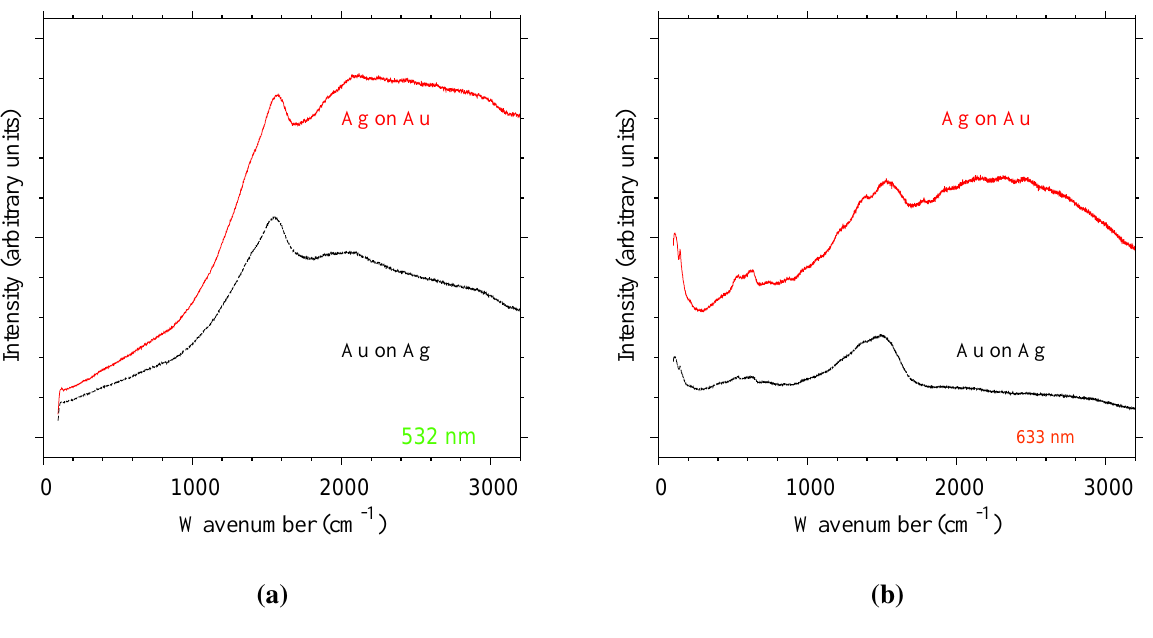
Figure 9. Raman spectra of Au-on-Ag and Ag-on-Au nanoparticles for excitation at ( a ) 532 nm and ( b ) 633